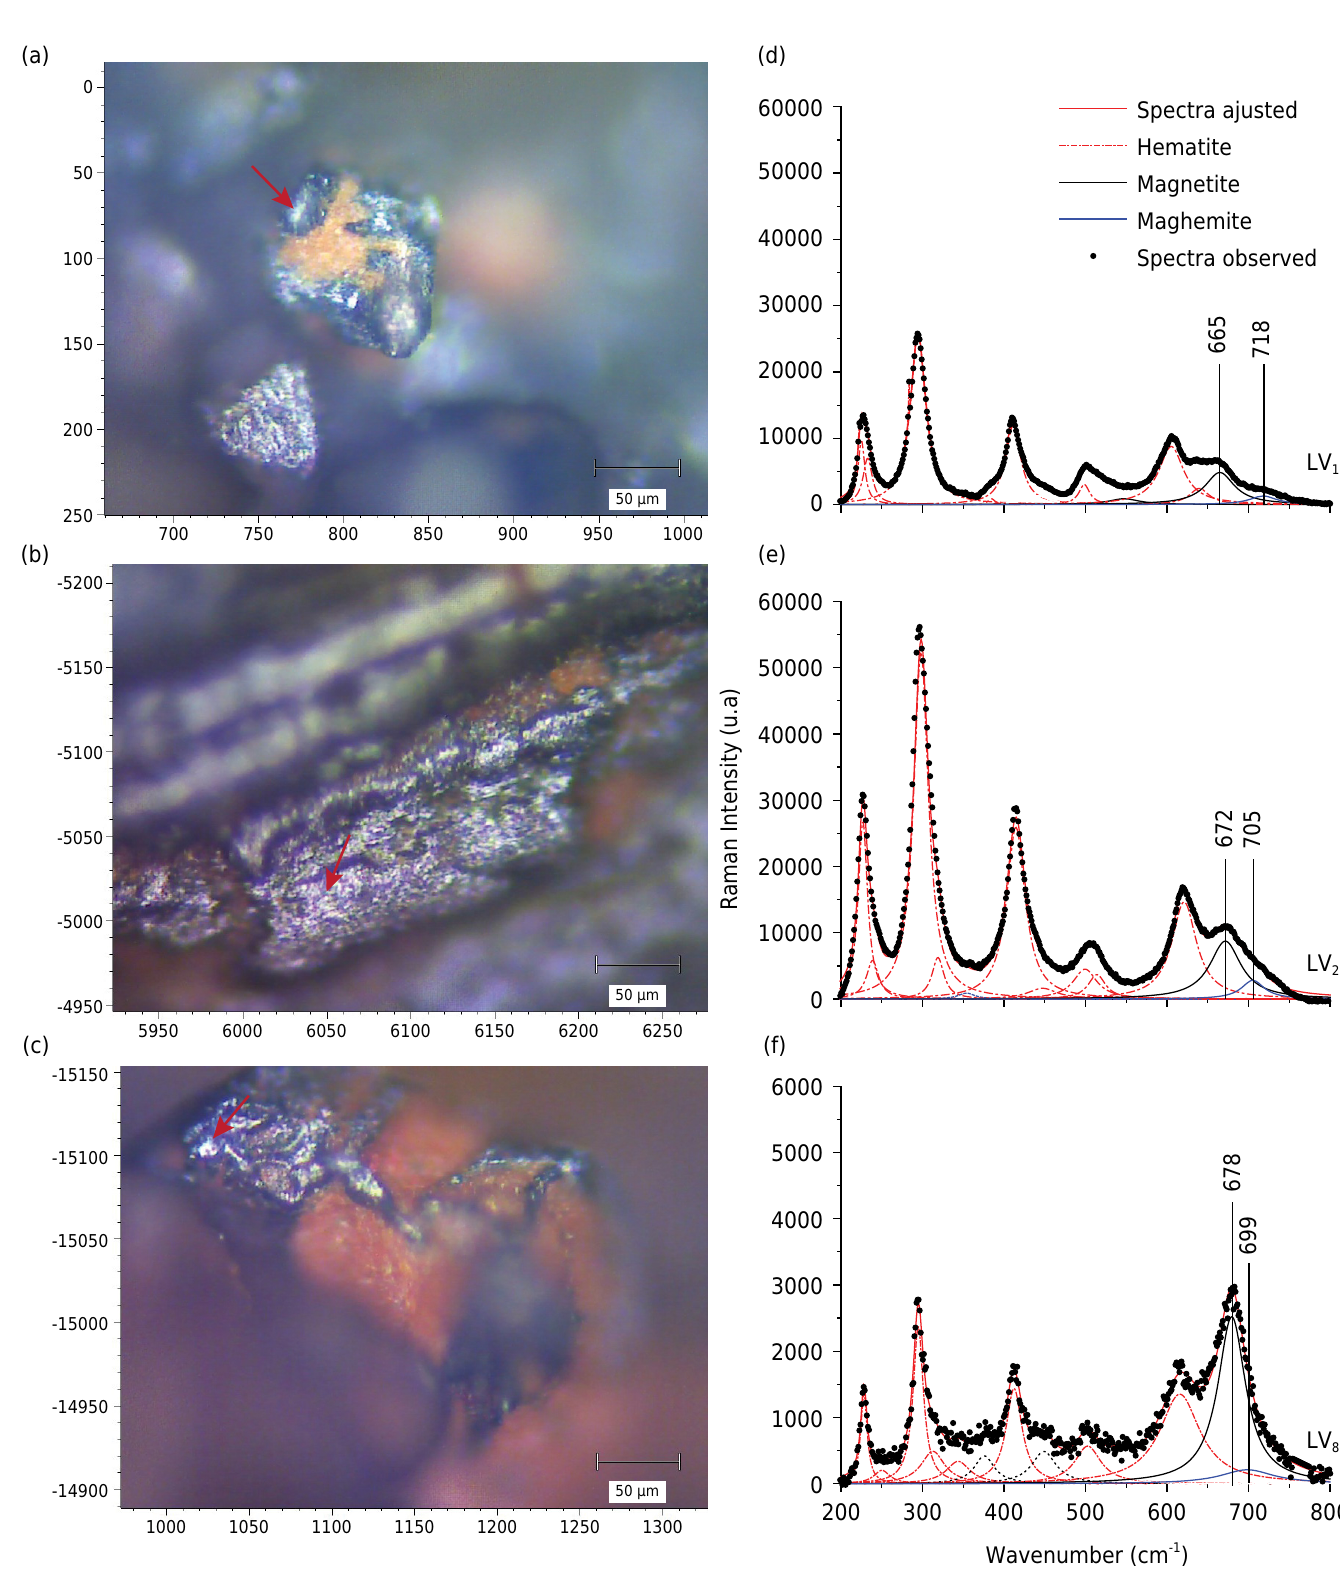
Figure 7. Particle surfaces of the sand magnetic fraction in selected soils LV 1 (a), LV 2 (b), and LV 8 (c) (scale of image = 50 µm) and their respective Raman spectra (d, e, and f). The white arrows indicate collection sites of Raman spectra (black color). These image patterns (a, b, and c) and Raman spectra (d, e, and f) are found in all